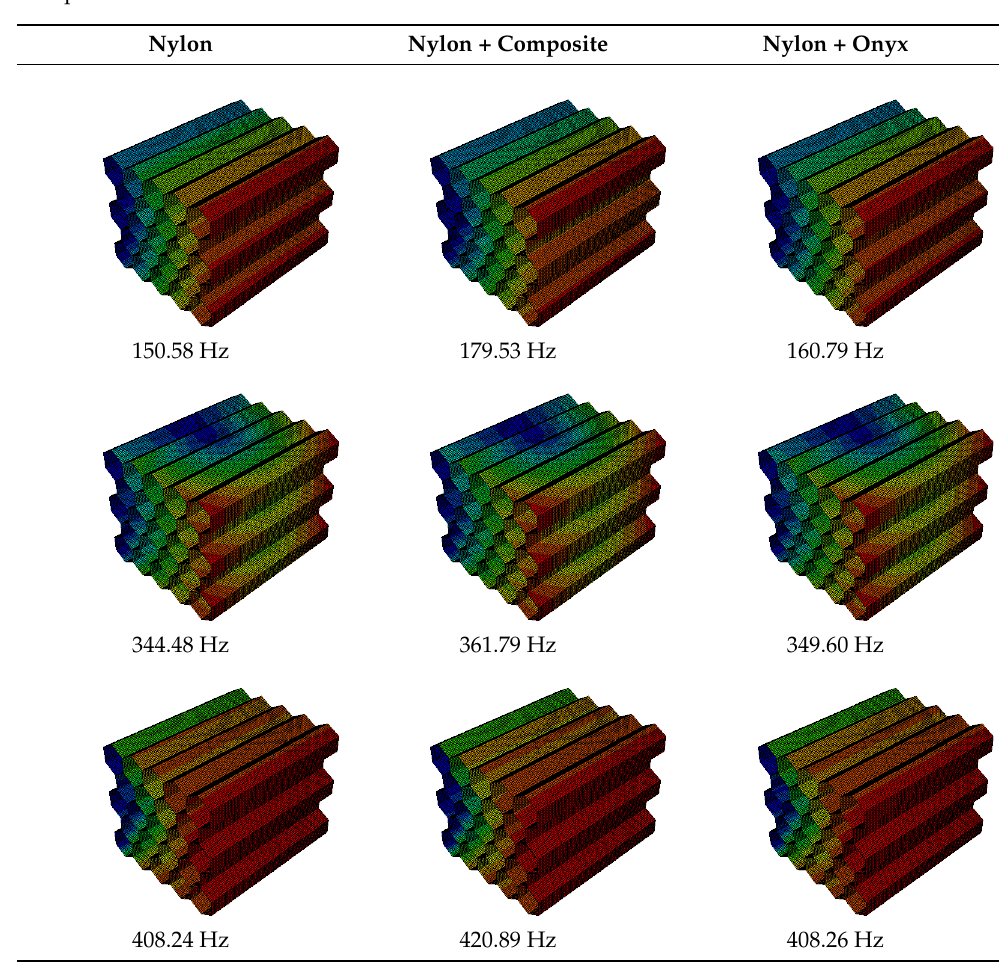
Table 8. First five paired mode shapes of Honeycomb Lattice Structure with right and left sides